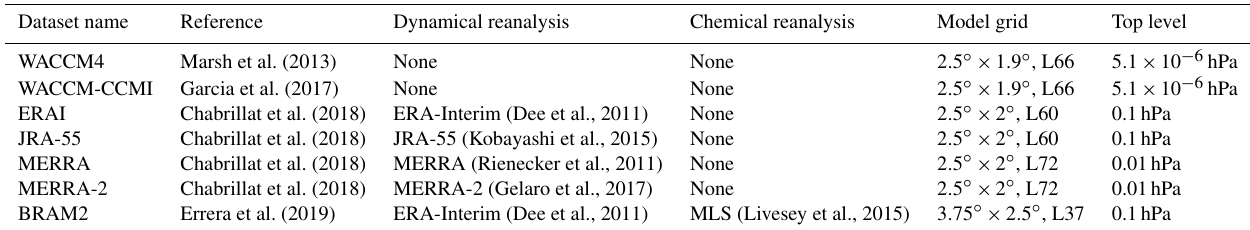
Table 1. Overview of the datasets used in this